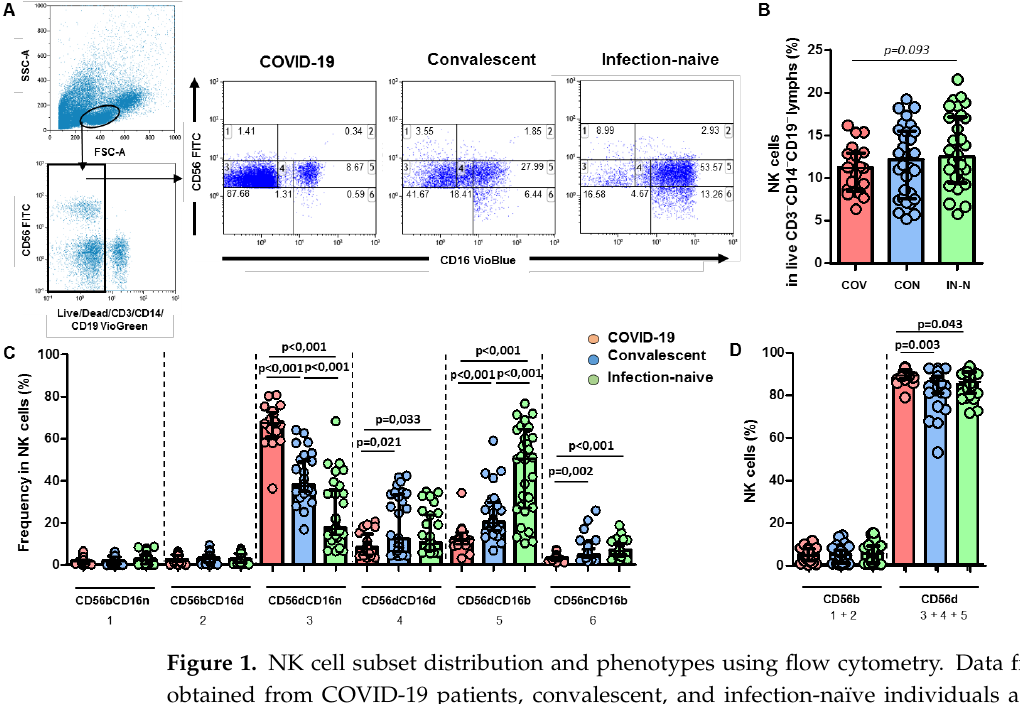
Figure 1. NK cell subset distribution and phenotypes using flow cytometry. Data from samples ob- tained from COVID-19 patients, convalescent, and infection-naïve individuals are presented. ( A ) Representative flow cytometry plots showing the gating strategy for NK cell phenotyping in CD3 neg CD14 neg CD19 neg lymphocytes using CD56 and CD16 antibodies. The percentage of each NK cell subset is shown. ( B ) Bar plot showing cumulative data regarding the frequency of total NK cells in COVID-19 patients (red, n = 20), convalescents (blue, n = 30), and infection-naïve (green, n = 30) individuals. One dot represents one patient. ( C ) Bar plots showing cumulative data regarding the relative frequencies of each subset among total NK cells in COVID-19 patients (red), convalescents (blue), and infection-naïve (green) individuals with the identification of each NK cell subset: subset 1 represents CD56 bright CD16 neg NK cells, subset 2 presents CD56 bright CD16 dim NK cells, subset 3 pre- sents CD56 dim CD16 neg NK cells, subset 4 presents CD56 dim CD16 dim NK cells, subset 5 presents CD56 dim CD16 bright cells, and subset 6 presents CD56 neg CD16 bright cells. The relative frequencies of each subset among NK cells are presented. ( D ) Bar plot showing cumulative data regarding the fre- quency of CD56 bright (subsets 1 and 2) and CD56 dim (subsets 3, 4, and 5) in COVID-19 patients (red), convalescents (blue), and infection-naïve (green) individuals. FSC-A, forward scatter-area; SSC-A, side scatter-area; statistically significant values are showed in bold when p < 0.05 and italic when p < 0.1.